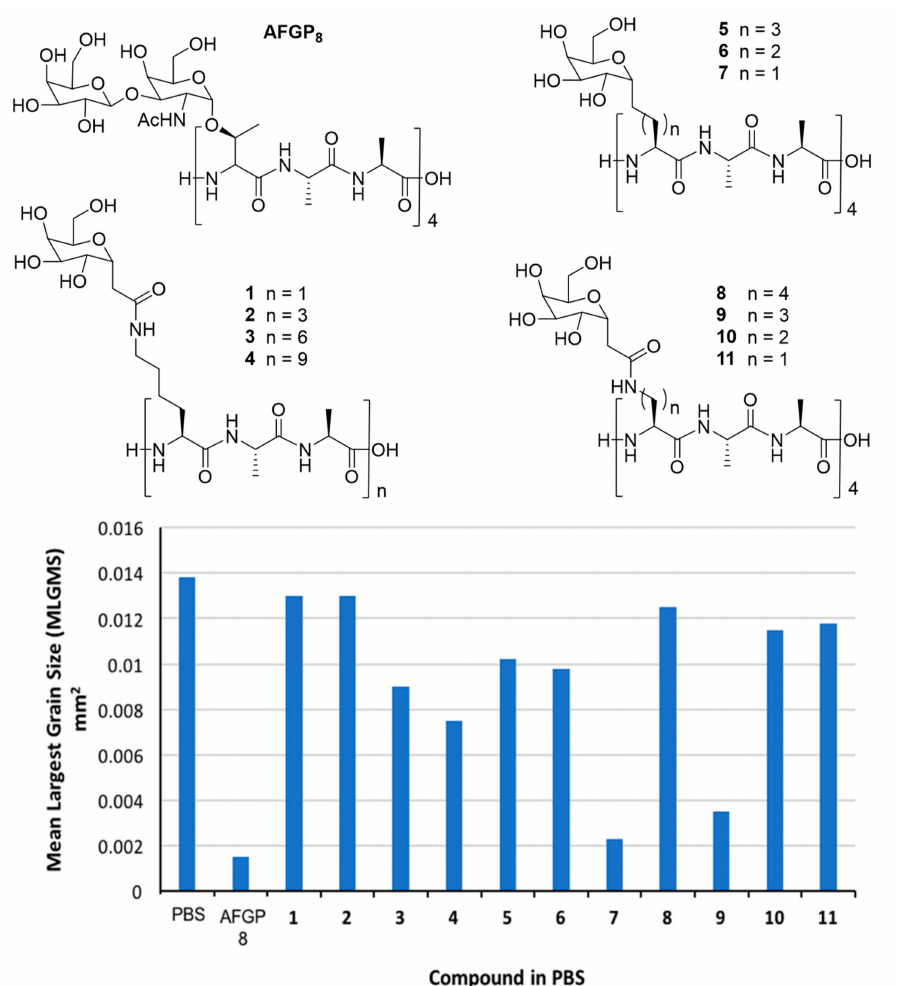
Figure 11. Set of di ff erent C-linked AFGP analogues synthesized using SPPS. The IRI activity of the di ff erent constructs was tested using the splat assay. Compound 7 shows similar potency in inhibiting ice recrystallization as the smallest AFGP (AFGP 8 ). Reprinted with permission of Pept. Sci. 2019 , 111